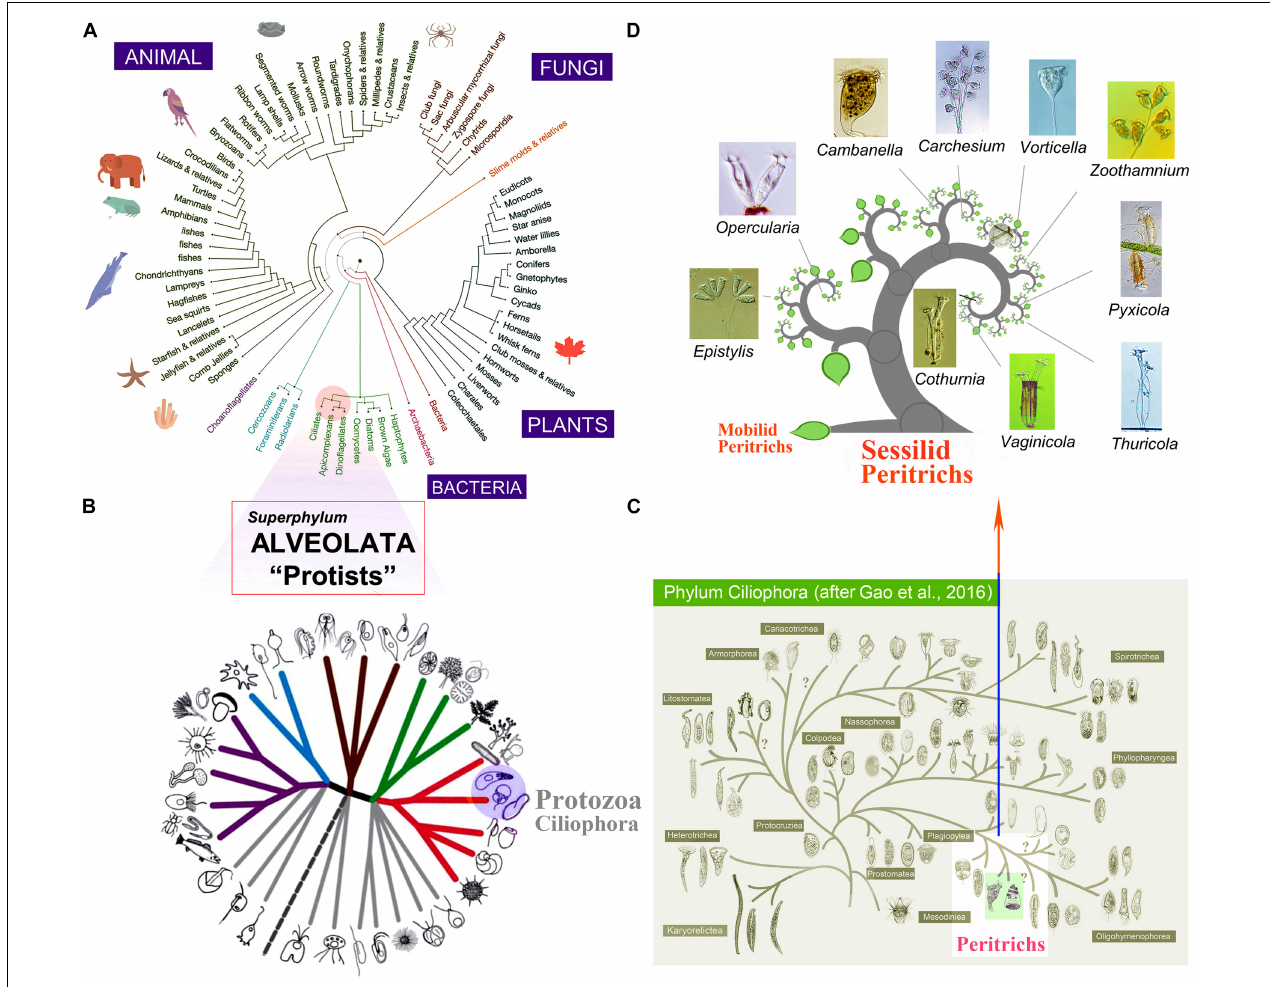
FIGURE 1 | Systematic arrangement of peritrichs in the evolutionary history and current taxonomy of phylum Ciliophora. (A) Tree of life, adapted from Pennisi (2003). (B) Classification of eukaryotes, adapted from Adl et al. (2019). (C) Classification of ciliates, adapted from Gao et al. (2016). (D) The phylogeny of peritrichs based on 18S rDNA gene sequences, generated by OneZoom (Rosindell and Harmon,